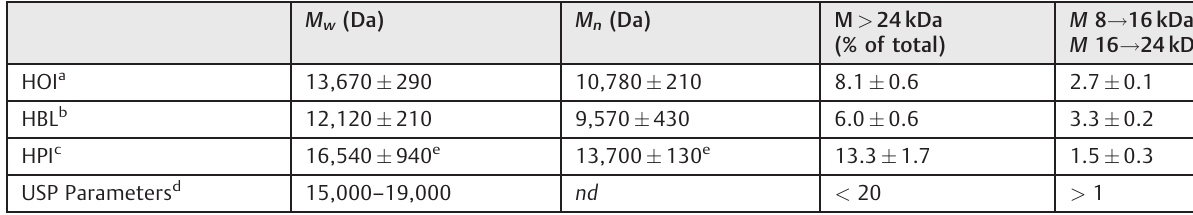
Table 1 Average weight molecular weight ( M w ), number average molecular weight ( M n ), proportions of heparin mass ( M ) lower than 24 kDa and M 8 ! 16 kDa / M 16 ! 24 kDa ratio of HOI, HBL and